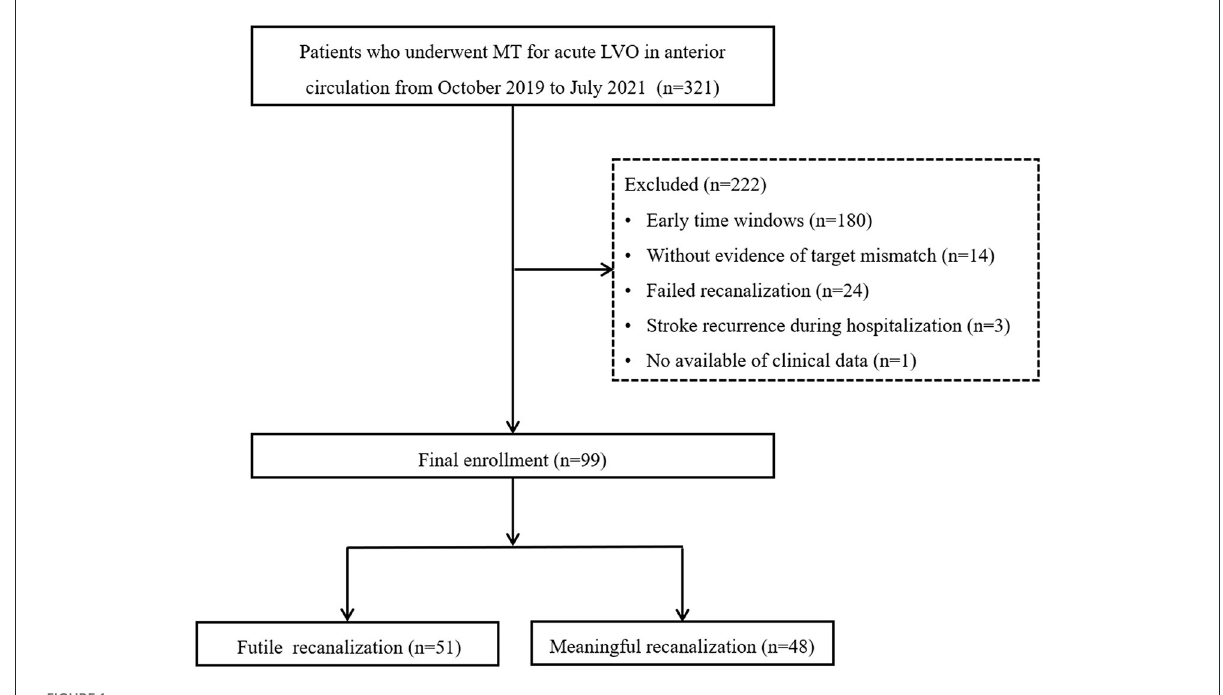
FIGURE1 Flowchart of patient selection. MT, mechanical thrombectomy; LVO, large vessel occlusion.